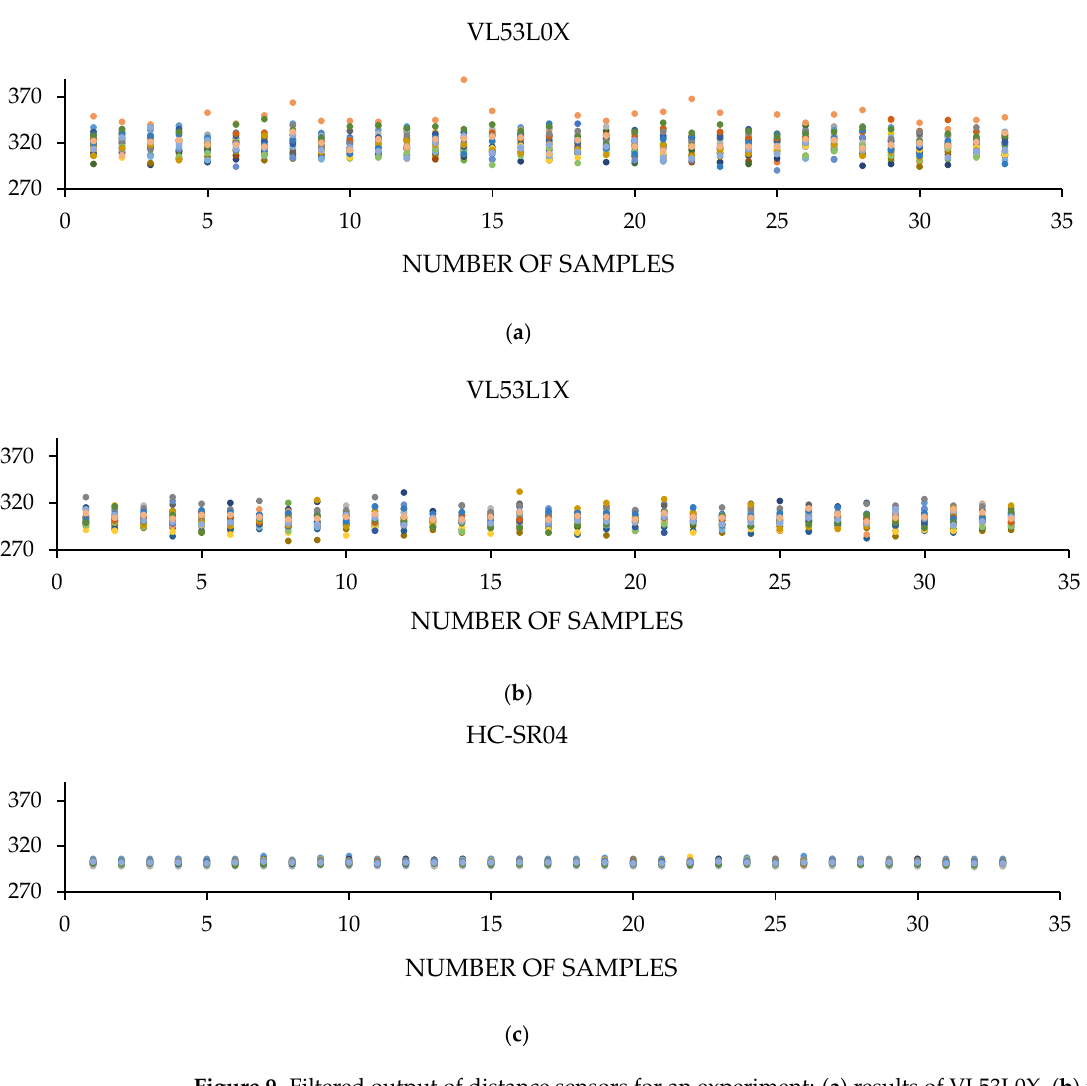
Figure 9. Filtered output of distance sensors for an experiment: ( a ) results of VL53L0X, ( b ) results of VL53L1X, and ( c ) results of HC-SR04.